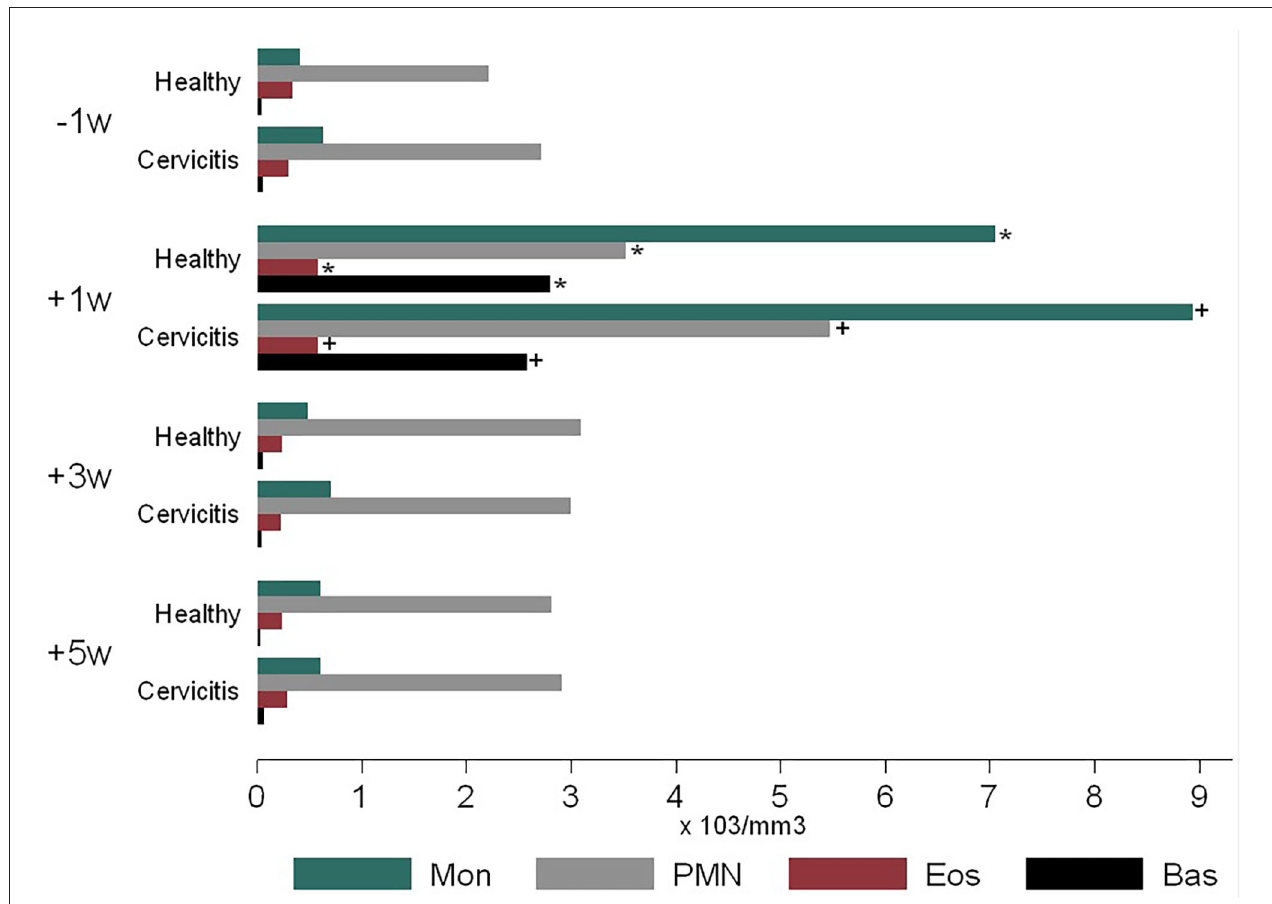
FIGURE 6 | Time-course variations in pre-and post-partum white blood cell count of cows ( n = 26) defined as clinical cervicitis cows ( n = 19) and healthy cows ( n = 7) from three dairy herds in Quebec in 2016. Time-course variations (weeks − 1w + 1w + 3w + 5w) of blood cell count ( × 103 mm 3 ) for monocytes (Mo), Neutrophils (Neu), Eosinophils (Eos), Basophiles (Bas). Body mark ( * ) indicates a significative difference in CH cows at p ≤ 0.05 for sample time comparison (weeks − 1w + 1w + 3w + 5w). Body mark ( + ) indicates a significative difference in CC cows at p ≤ 0.05 for sample time comparison (weeks − 1w + 1w + 3w + 5